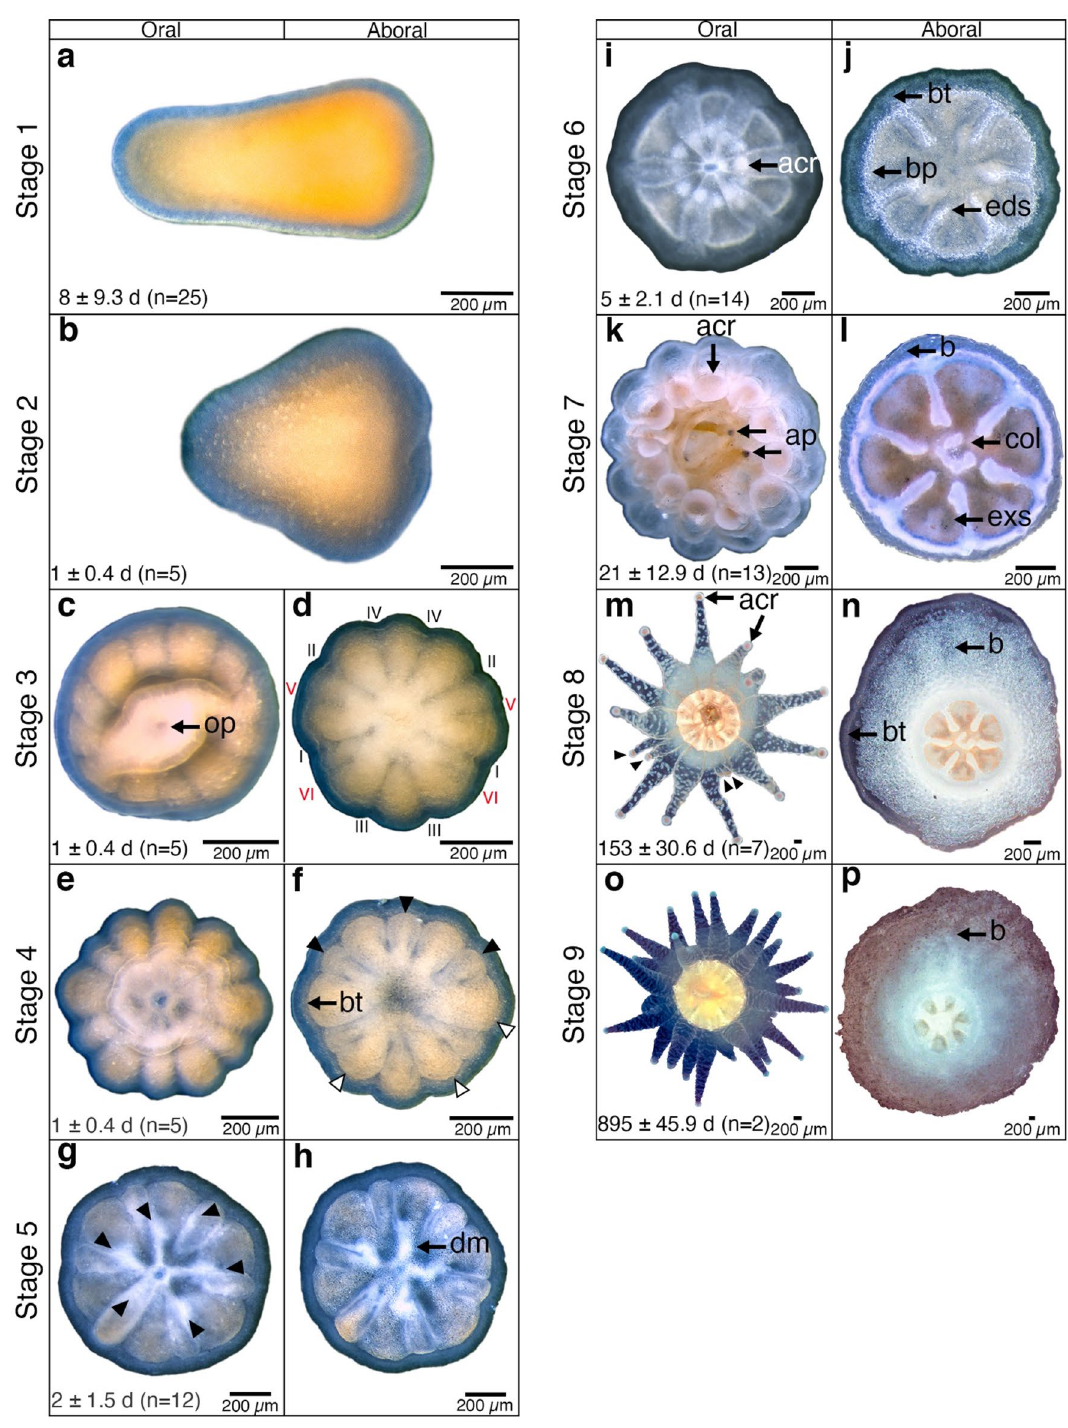
Figure 5. Caryophyllia huinayensis from larva to juvenile polyp (compiled from three recruits) observed under a stereomicroscope. Columns indicate the perspective (left oral/right aboral), and rows show the number of days (mean ± SD) from attachment to reach the respective stage. For description of Stages 1–9, see main text. acr: acrosphere, ap: A. persimilis -nauplii, b: base, bp: basal plate, bt: bilayered tissue, col: columella, dm: